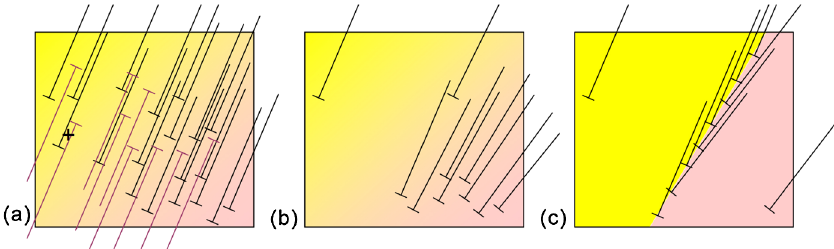
FIG. 13. (Color) Schematic diagram of recovery: (a) after plastic deformation, statistically stored dislocations climb and glide to find annihilation partners (e.g. location marked with þ ), leaving only (b) geometrically necessary dislocations which can (c) arrange themselves into low energy low angle boundaries with